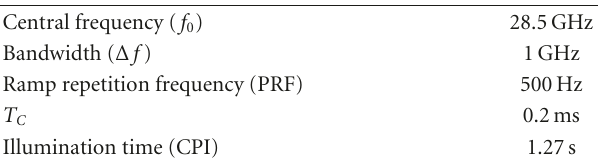
Table 5: Real radar parameters for the acquired data corresponding to the vessel in Figure